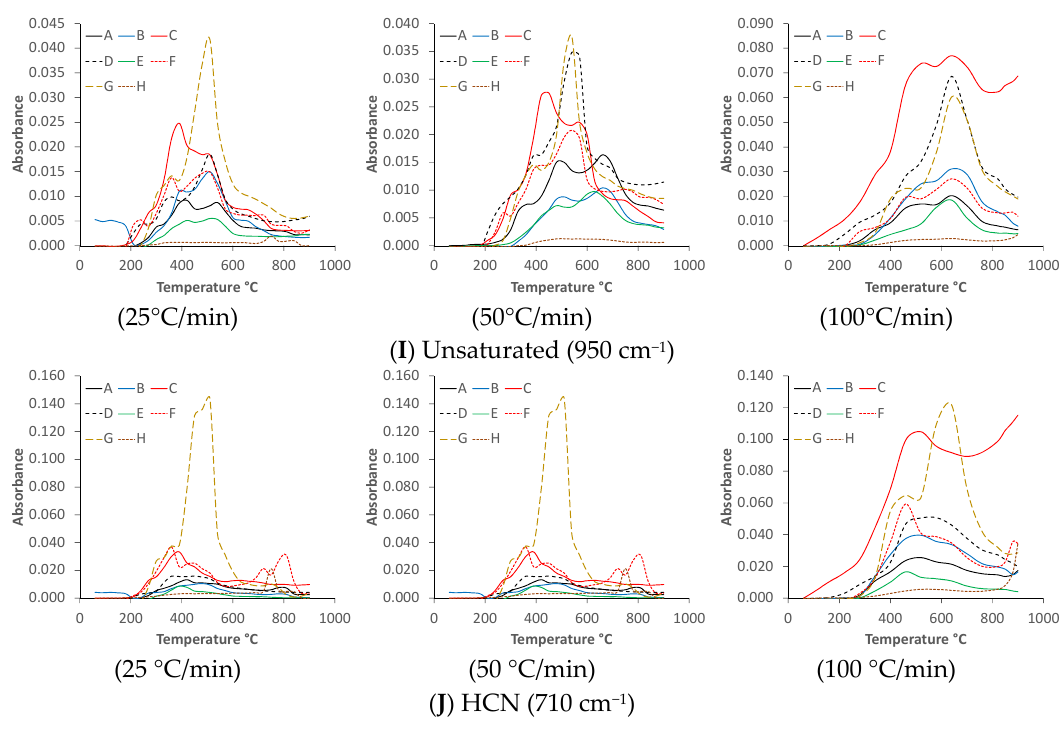
Figure 3. Summarized FTIR results.